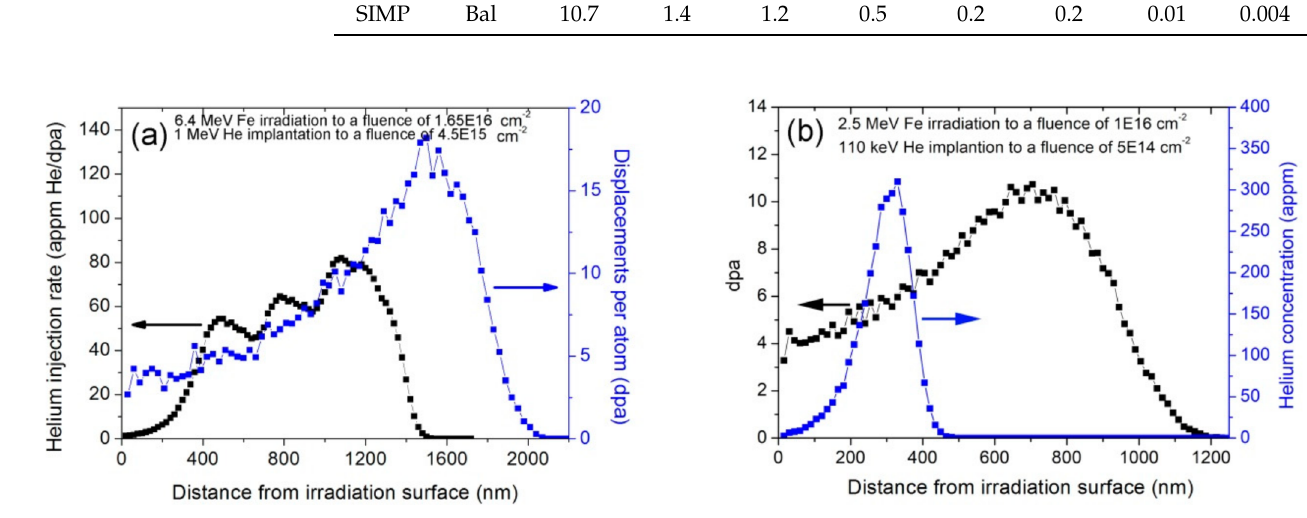
Figure 1. Depth profiles of displacement damage induced by Fe irradiation and of helium deposition via ( a ) dual-beam, ( b ) single-beam, simulated by